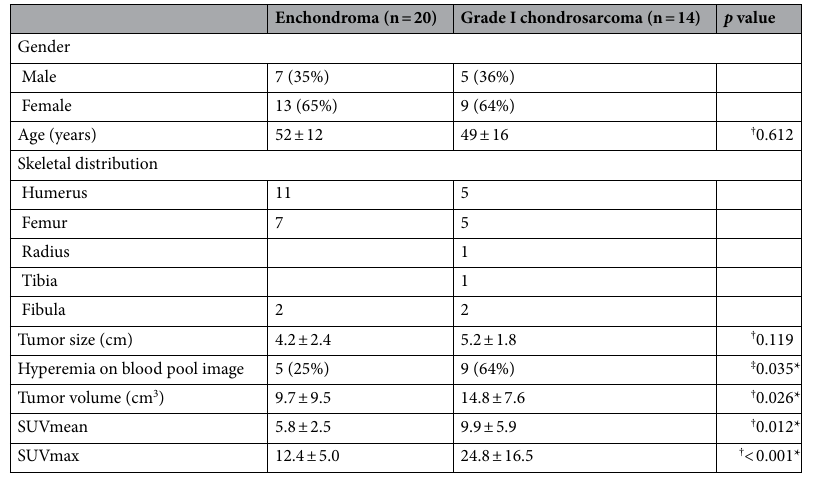
Table 1. Clinical characteristics and SPECT/CT findings in patients with enchondroma and grade I chondrosarcoma. † Mann–Whitney U test. ‡ Fisher’s exact test. *Statistically significant.